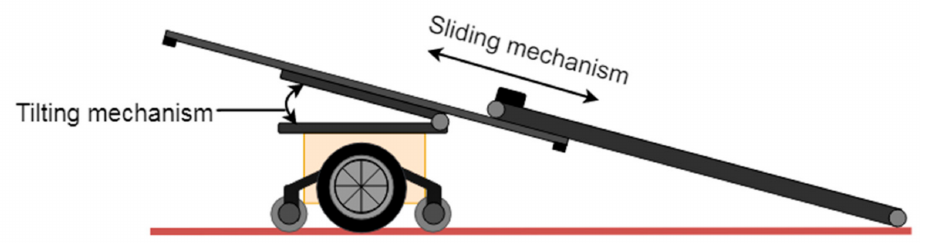
Figure 5. Illustration of proposed tilting mechanism and sliding mechanism adapted in the ResQbot 2.0 proposed design. These mechanisms were adapted in order to accommodate the upgraded size of the stretcher bed—capable of loading the entire body of an average-size casualty—while maintaining the overall compact design of the robot.